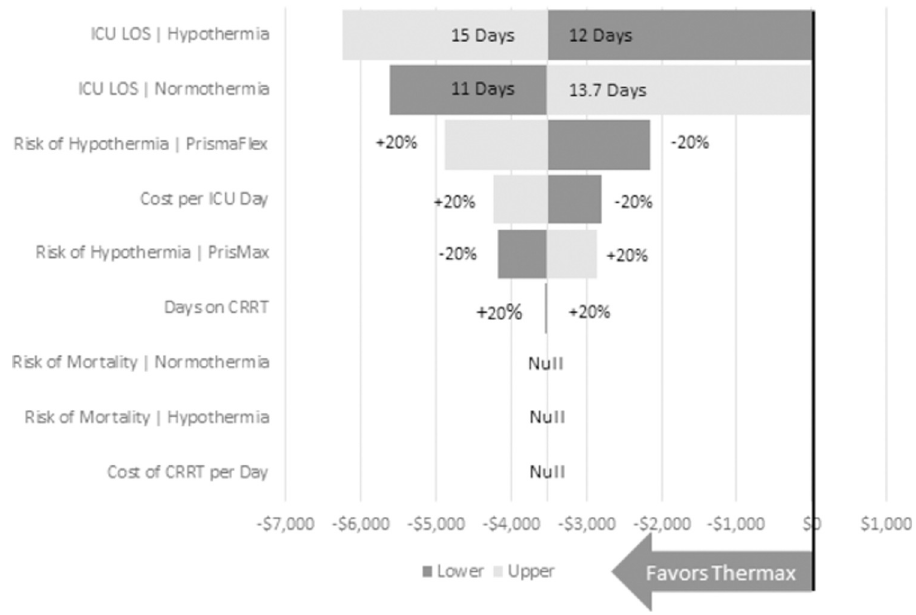
Fig 1. Deterministic sensitivity